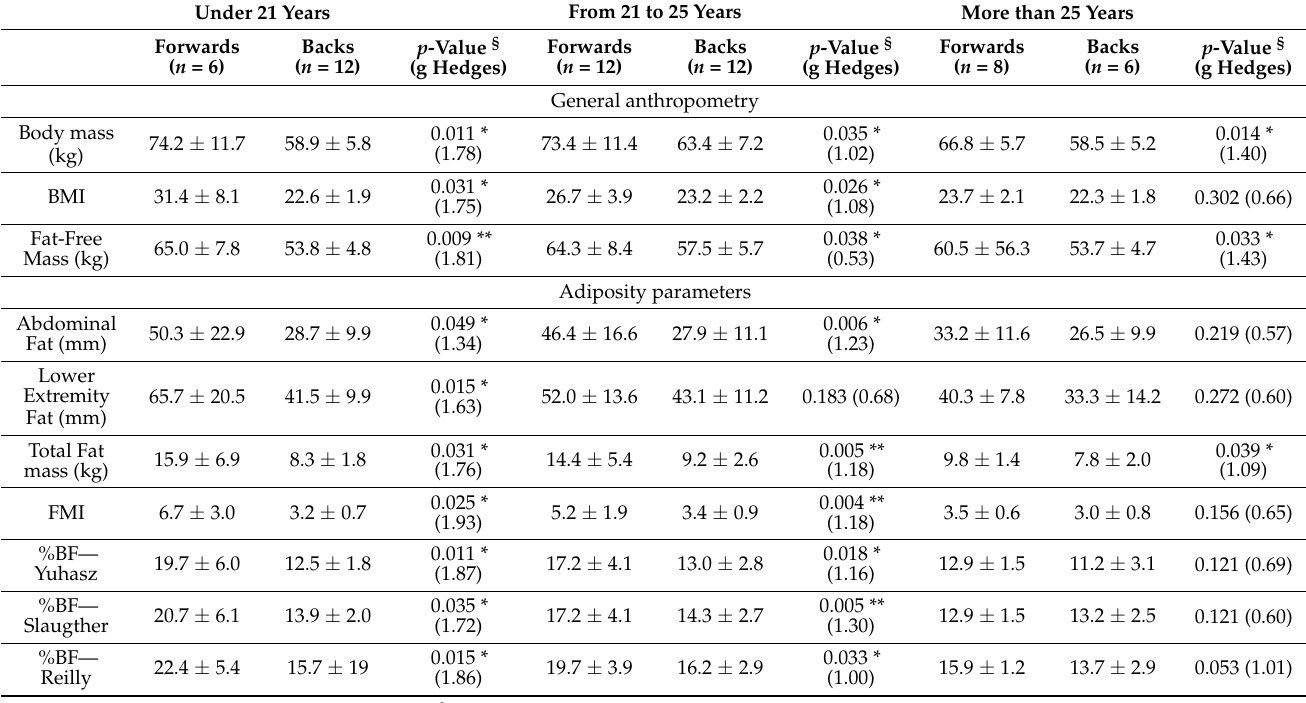
Table 3. General anthropometric data, adiposity parameters, and lean measurements of forward and back players of the three age groups.